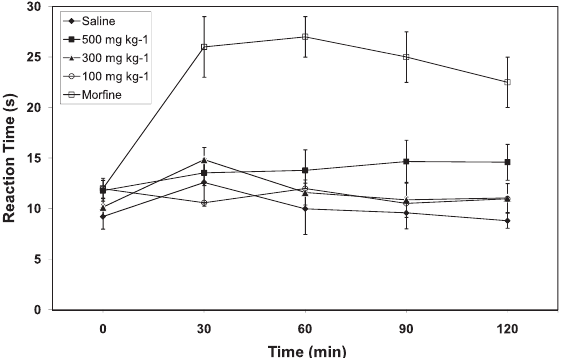
Fig. 3 - Analgesic effect (mg Kg -1 ) of HF on the Hot Plate test. O time = baseline (Data expressed as mean ± S.E.M. n = 10 mice/group; ANOVA; Bonferroni’s